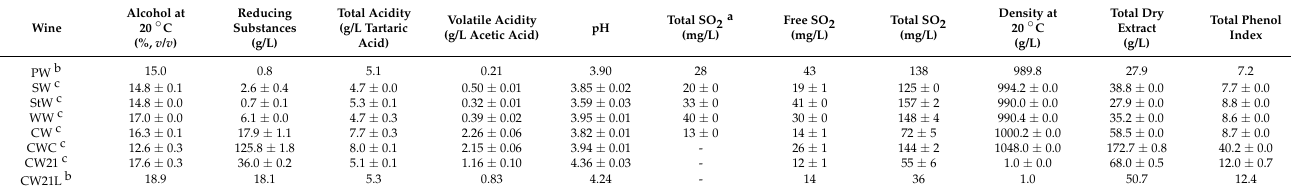
Figure 3. Semi-industrial scale wine fermentation in the harvest of 2021 (horizontal black bars represent the standard deviation of the mean of two repetitions). Table 3. Wine physicochemical